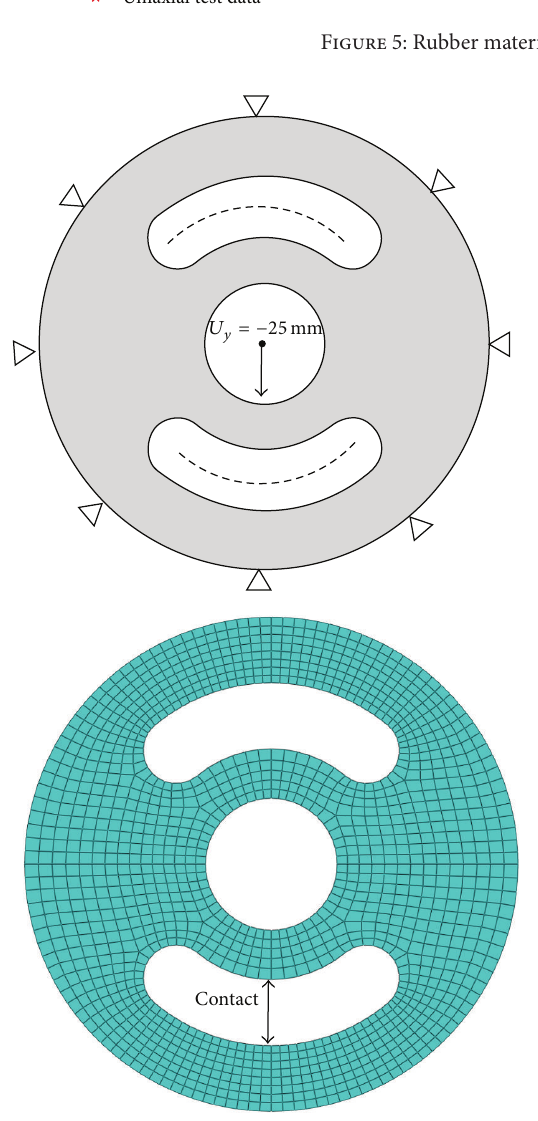
Figure 6: Boundary conditions and finite element model of bush-